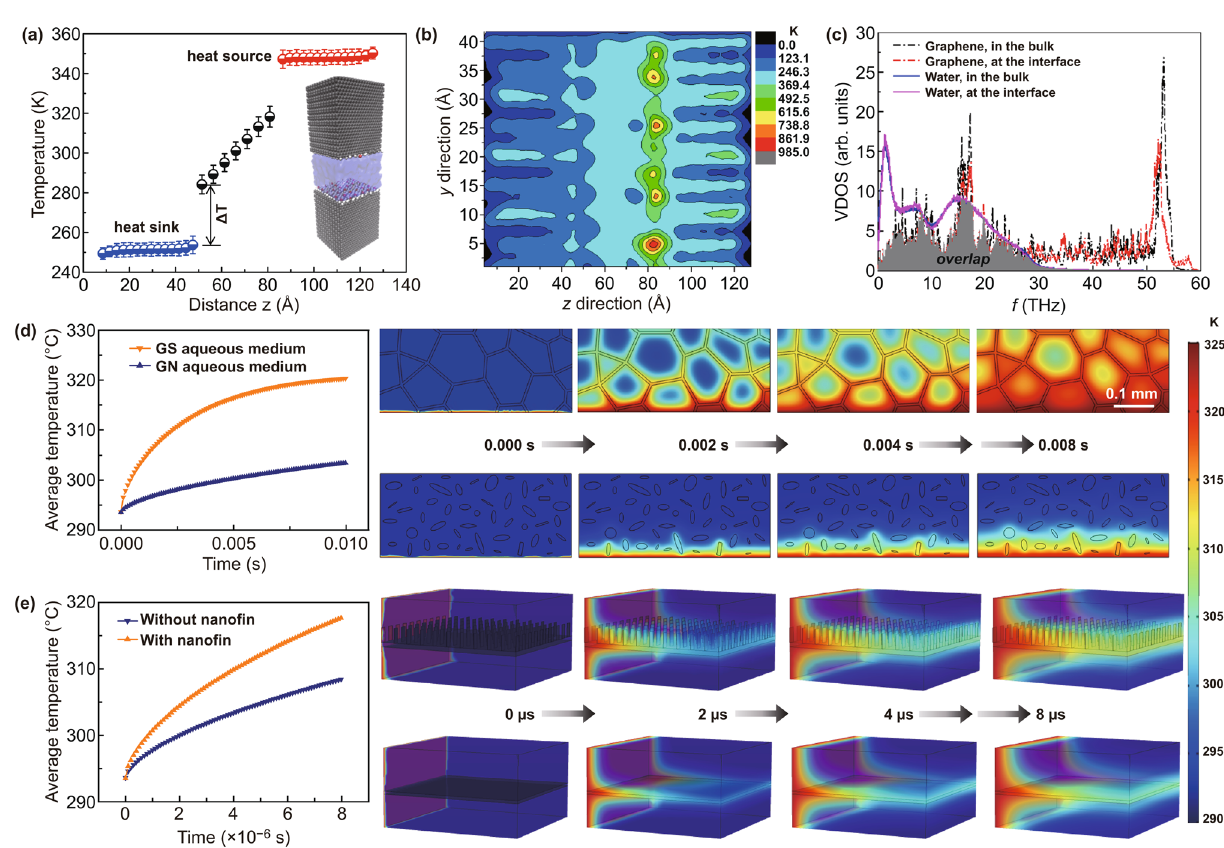
Fig. 3 a 1D and b 2D temperature distribution at the graphene–water interface. c VDOS of graphene and water at the interface. d Averaged temperature of the GN and 3D-GS aqueous medium. e Average temperature of 3D-GS-CBF and 3D-GS aqueous mediums during the finite ele- ment method